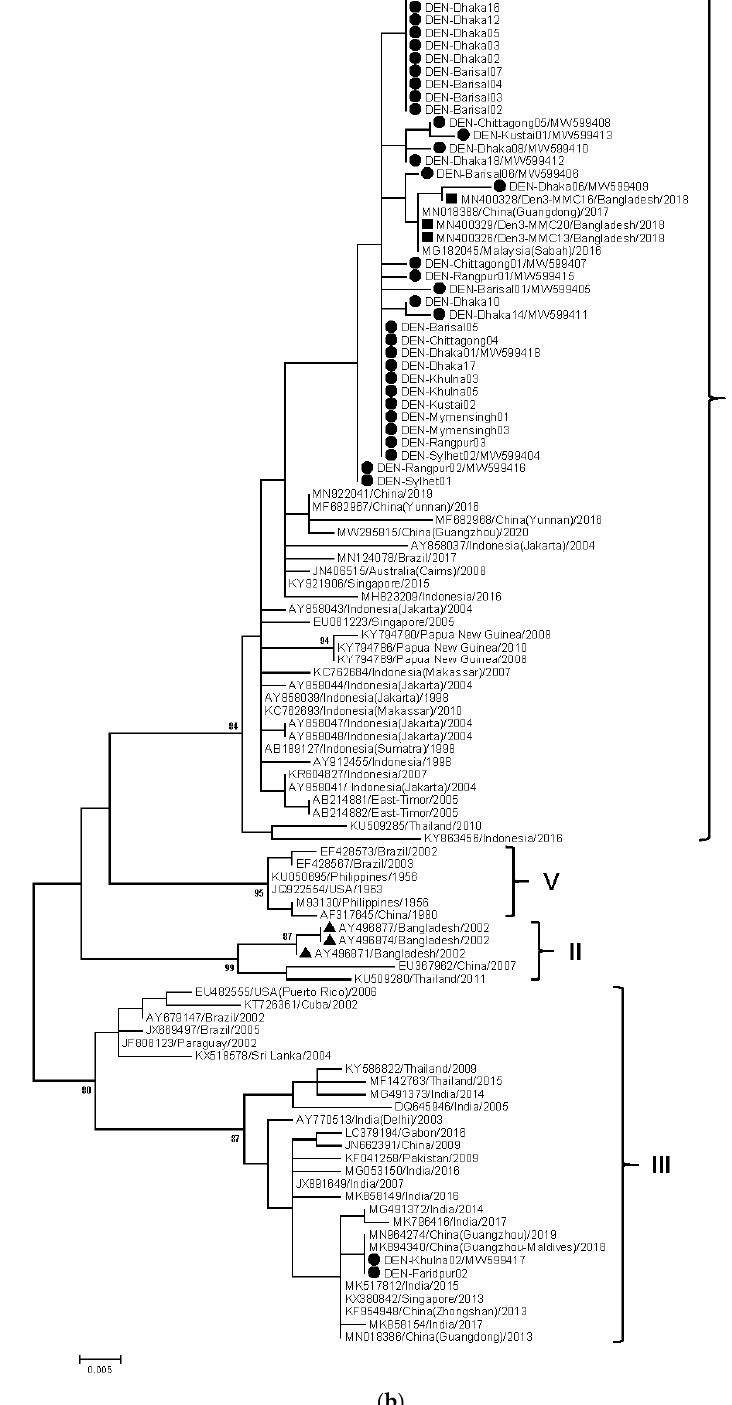
Figure 3. Phylogenetic dendrogram of partial C-prM gene of DENV-2 ( a ) and DENV-3 ( b ) in Bangladesh in 2019 outbreak and other diverse geographical locations, constructed using the maximum-likelihood method with the MEGA6 software package. Variation scale is described at the bottom. Percentage bootstrap support is indicated by the values at each node (values <80% were omitted). Closed circles and squares indicate DENV-2/DENV-3 in the present study (2019) and those reported previously (2018) in Dhaka [13], respectively. Triangles represent DENV-3 strains detected in Bangladesh in 2002. Genotypes of DENV-3/DENV-2 are shown on the right. Two DENV-3 samples were not included in dendrogram ( b ) because their nucleotide sequence length was considerably shorter than other